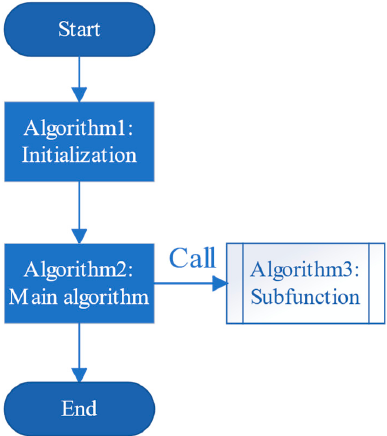
Figure 2. Flow chart diagram of preallocated sequential routing (PSR).